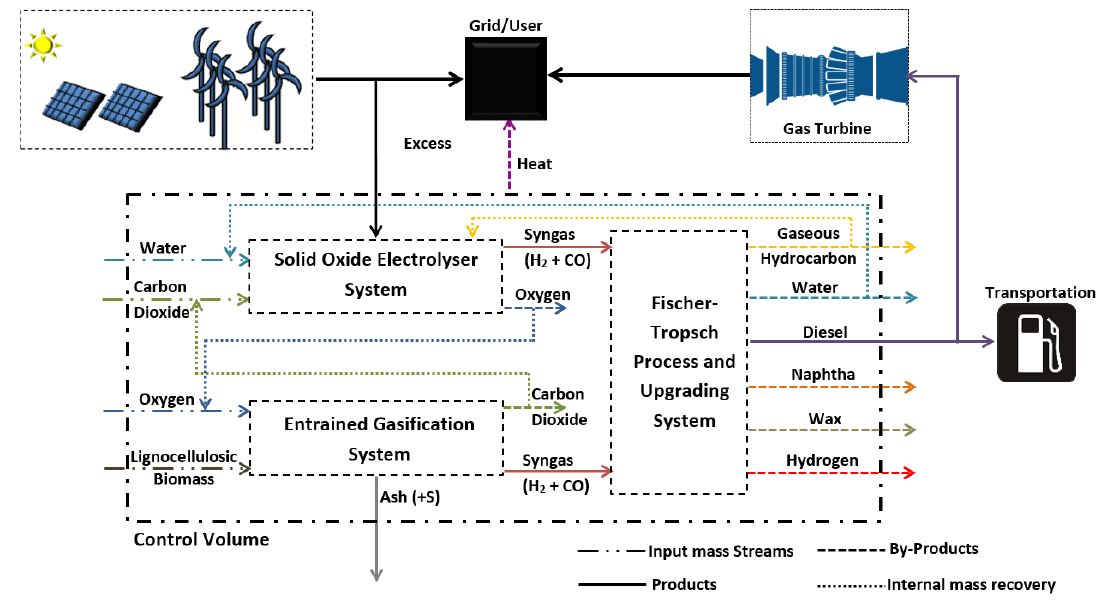
Figure 1. Integrated system schematic.